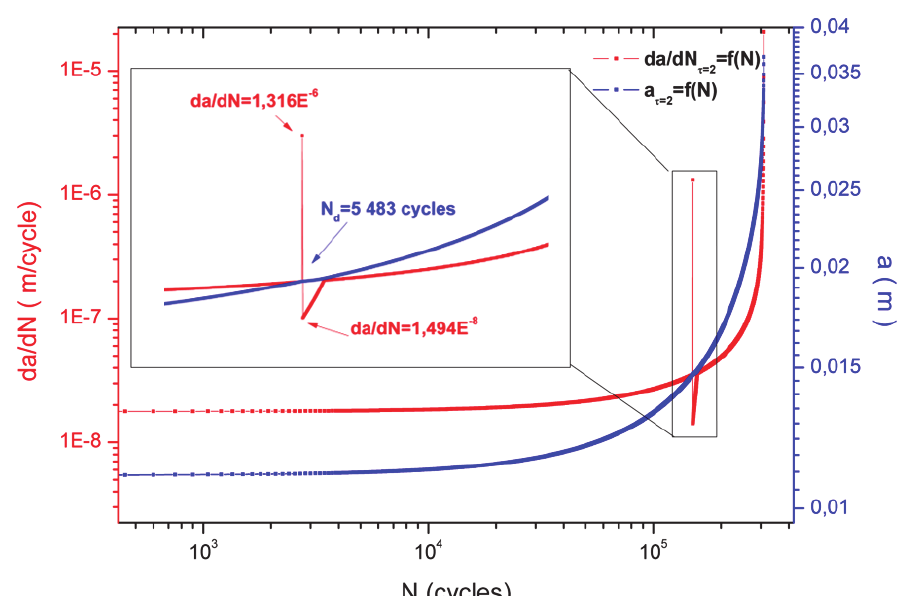
Figure 5: Evolution of the cracking rate and crack propagation as a function of the number of cycles for an overload rate ( τ = 2). By observing both Figs. 5 and 6, we can deduce and advance several